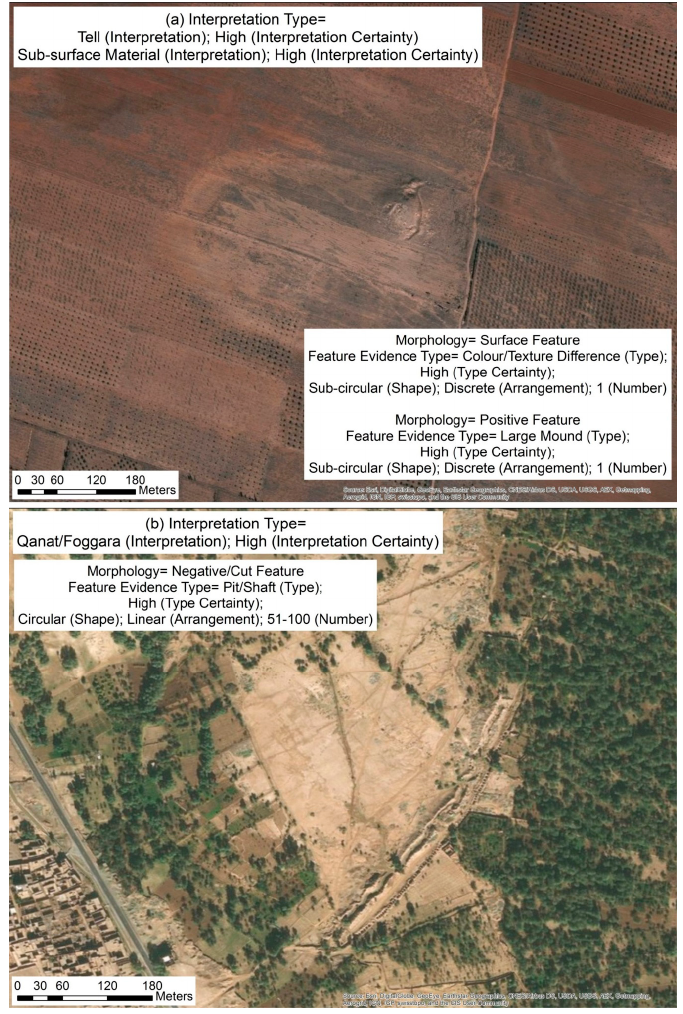
Figure 3. The EAMENA Interpretation of sites and features, using example terminologies from our Evidence Type and Interpretation glossaries. ( a ) In this case the team have identified a tell site (Syria) and ( b ) a qanat/foggara system (Morocco).